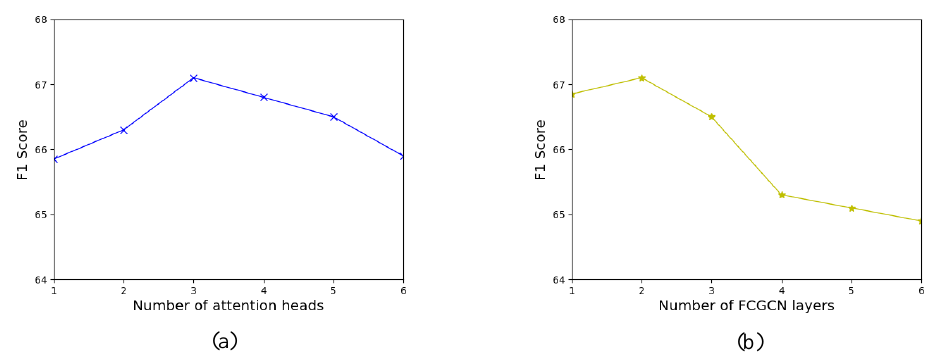
Figure 5. Effect of hyper-parameters. ( a ) Results on different number of attention heads h . ( b ) Results on different Number of FCGCN layers d l